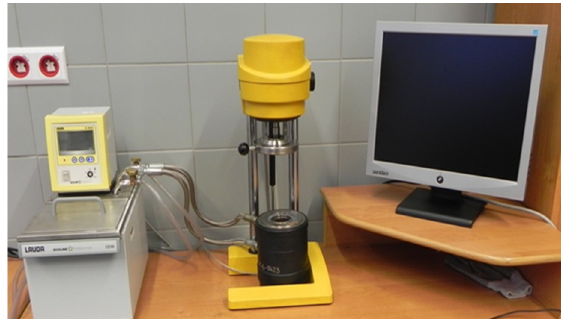
Figure 16. Rheotest viscometer (photo by M. M. Iwa ń ski).